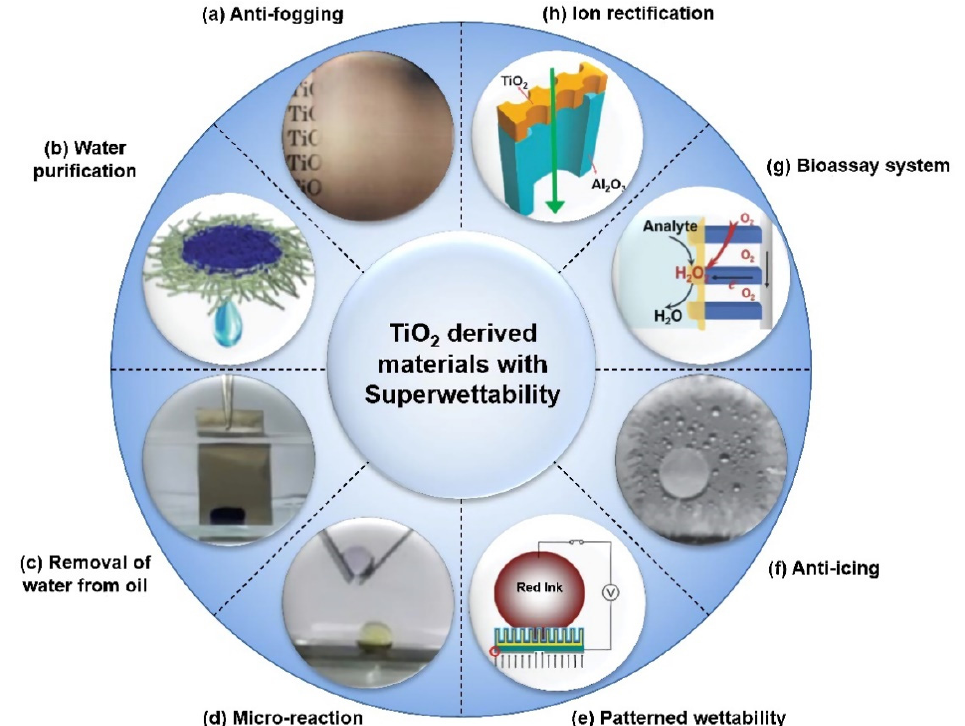
Figure 1. Typical applications of TiO 2 based on photo-induced superwettability. ( a ) Glass substrate coated with nano-TiO 2 shows anti-fogging properties. Reprint from [11]. Copyright (1997), with permission from Nature Publishing Group, Basingstoke, UK. ( b ) Water can be purified through a TiO 2 nanomembrane by adsorption of organic pollutants. Reprint from [32]. Copyright (2013), with permission from The Royal Society of Chemistry, London, UK. ( c ) Removal of water from oil with UV-illumination on a superhydrophilic TiO 2 nanotube array (TiO 2 -NTA) surface. Reprint from [33]. Copyright (2018), with permission from American Chemical Society, Washington, DC, USA. ( d ) Under-oil microreaction on the fabricated superhydrophilic TiO 2 -NTA surface. Reprint from [33]. Copyright (2018), with permission from American Chemical Society, Washington, DC, USA. ( e ) Patterned wettability used for printing on the TiO 2 surface via the photoelectric cooperative